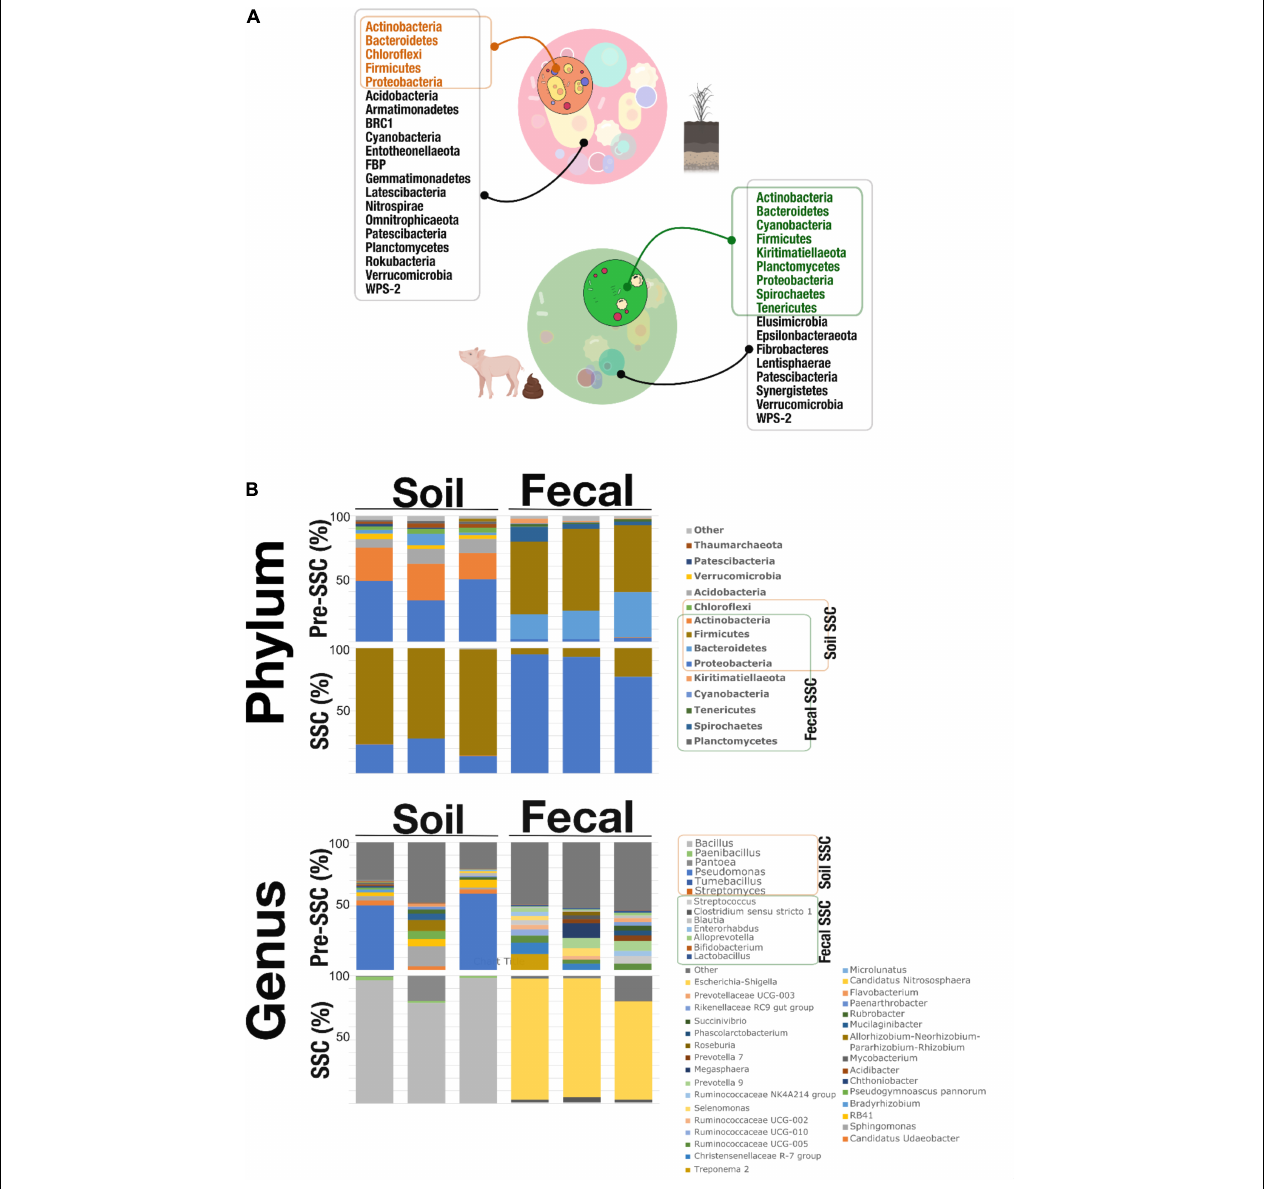
FIGURE 2 | (A) SSC members (phyla) that were recovered through the SSC strategy. The soil SSC structure was able to capture Actinobacteria, Bacteroidetes, Chloroflexi, Firmicutes, and Proteobacteria which overlapped with the pre-SSC. Fecal SSC identified Actinobacteria, Bacteroidetes, Cyanobacteria, Firmicutes, Kiritimatiellaeota, Planctomycetes, Proteobacteria, Spirochetes, and Tenericutes that were also present in the fecal pre-SSC structure. This proved that the SSC strategy was able to simplify complex communities from different systems (soil and fecal) at the level of phyla. (B) Stacked bar plots showing the relative abundance of the microbial community, at the phylum and genus level, in pre-SSC and SSC soil and fecal